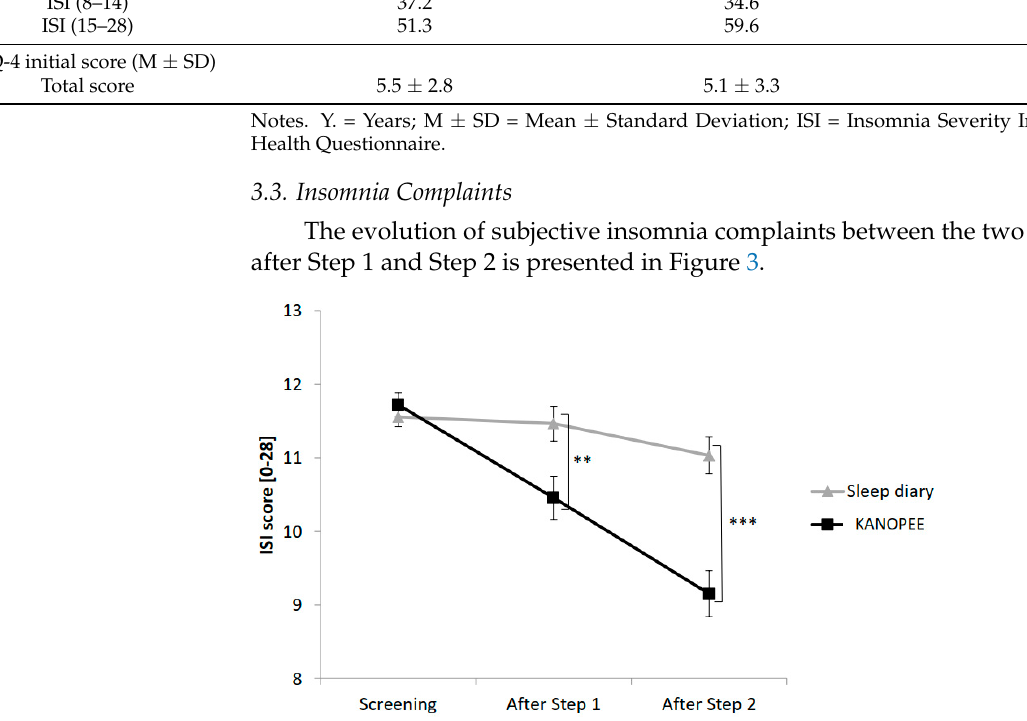
Figure 3. Insomnia severity index according to sleep diary versus KANOPEE over time. Note: